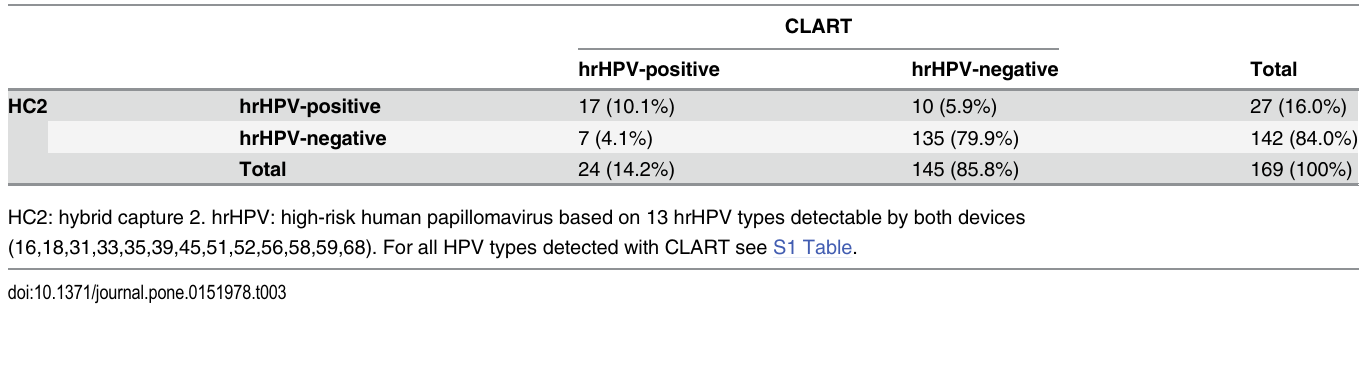
Table 3. Concordance/discordance between CLART and Hybrid Capture 2